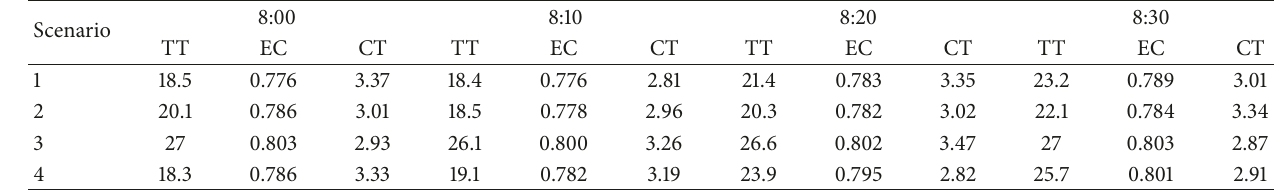
Table 5: The results under four scenarios from node 1 to node